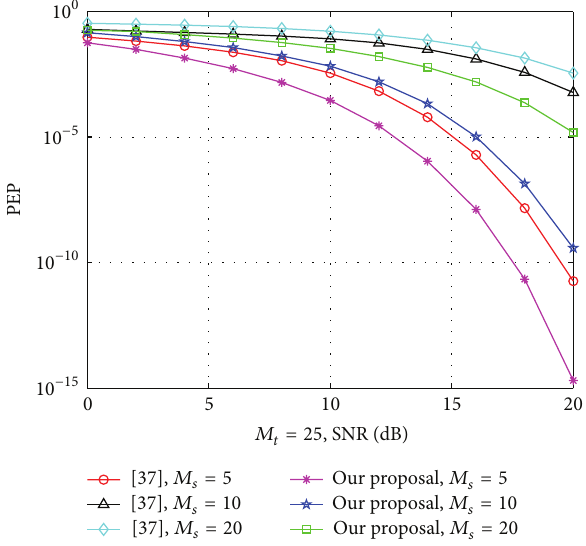
Figure 11: 𝑀 𝑡 = 25 , conditional PEP versus